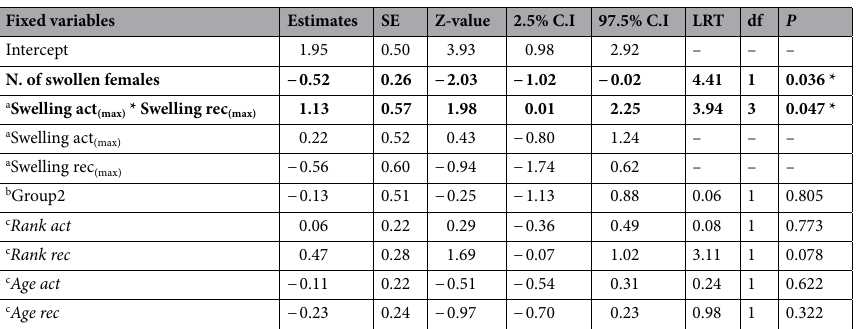
Table 1. Variables in Model 1 explaining the daily grooming preference while controlling for rank and age of both actor and receiver. LTR = likelihood-ratio test. Control variables are in italics and explanatory variables with significant P values are in bold and marked with * a Swelling condition “min” as reference category. b Group1 as reference category. c z-transformed to a mean of 0 and a standard deviation of 1.